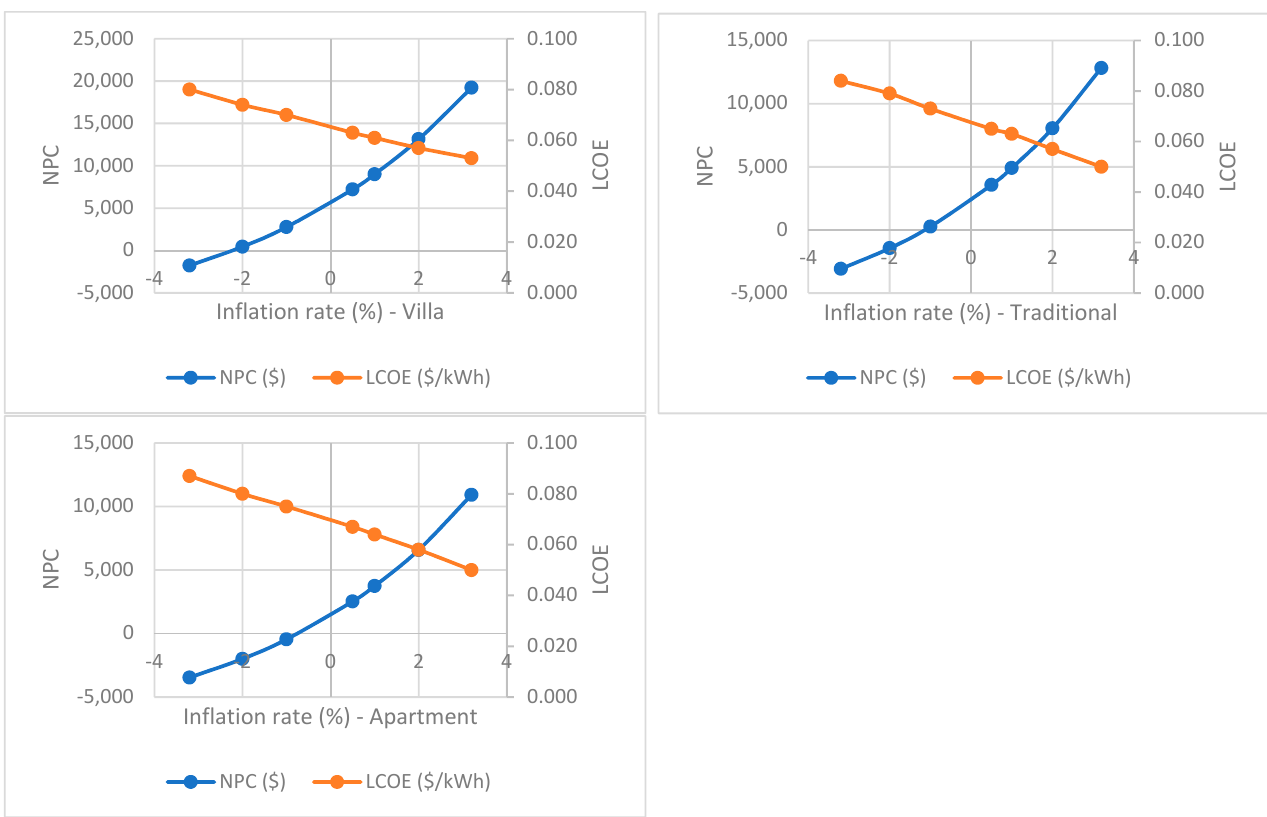
Figure 8. Effect of discount rate variability on NPC and LCOE for villa, traditional dwelling, and apartment. Between January 2018 and June 2020, the KSA’s inflation rate fluctuated between − 3.2% to +3.2% and Figure 9 shows how energy costs depend on the inflation rate. We see LCOE is almost linearly related to inflation rate over the range investigated [49].